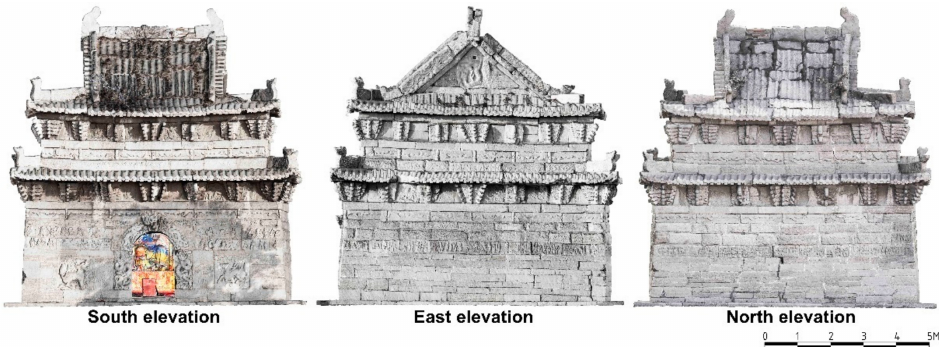
Figure 17. Elevation diagram of the current situation of the Limestone Hall (currentstatus).